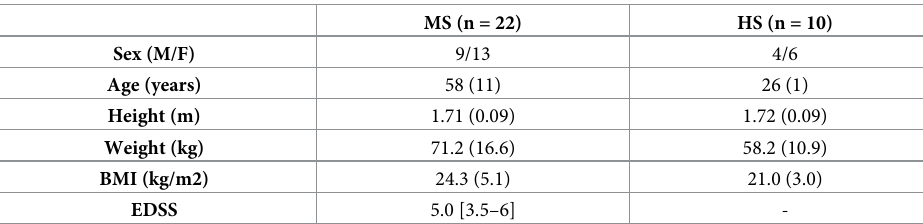
Baseline characteristics of patients with multiple sclerosis (MS) and healthy subjects (HS). For the age, height, weight and body mass index (BMI), the mean and the standard deviation (SD) are displayed. For the Expanded Diseases Status Scale (EDSS) the statistics are reported as median and interval quartile range